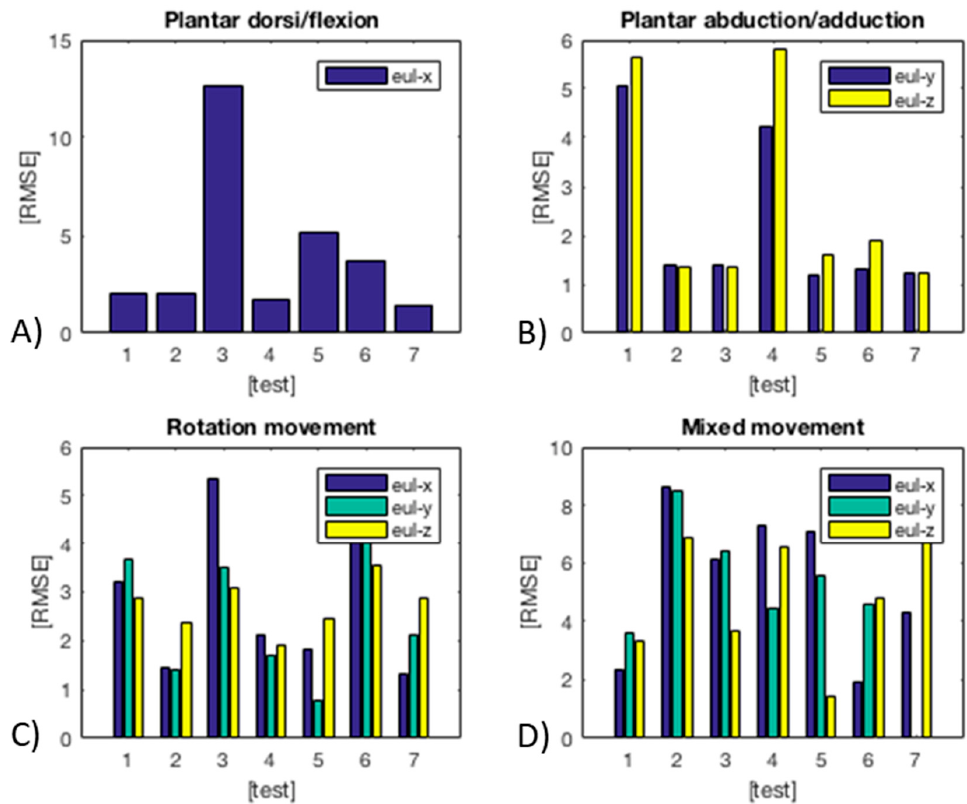
Figure 14. RMSE in seven different tests for each movement: ( A ) Plantar dorsi/flexion; ( B ) Plantar abduction/adduction; ( C ) Rotation; ( D ) Mixed movements.